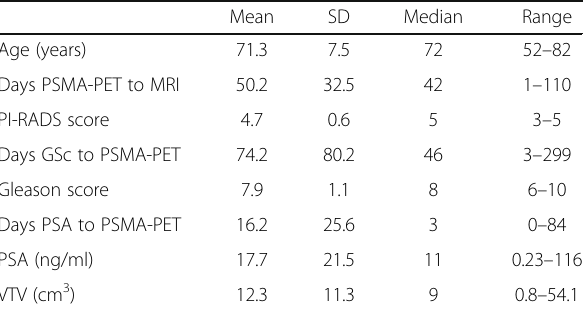
Table 1 Characteristics of study